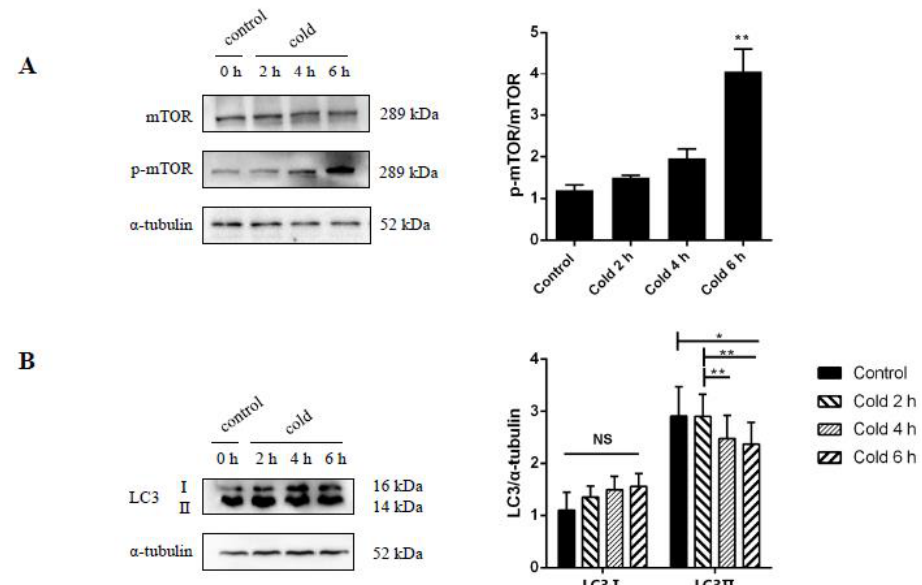
Figure 7. Effect of acute cold stress on the expression of mammalian target of ( A ) rapamycin (mTOR) phosphorylation and ( B ) LC3-II proteins in the liver. The data are presented as mean ± SEM ( n = 8). Statistically significant differences are indicated, * p < 0.05 and ** p < 0.01. NS: not significant.